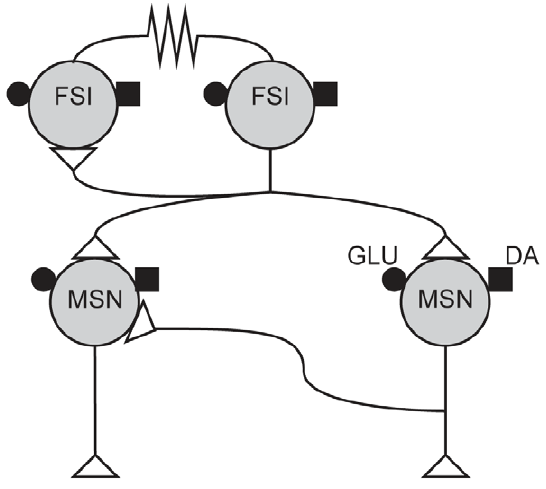
Figure 1. The striatal GABAergic microcircuit studied in this paper. Primary input to the striatum comes from glutamatergic (GLU: . ) fibres originating in the neocortex, thalamus, hippocampal formation and amygdala, and dopaminergic (DA: & ) fibres originating in the hindbrain dopaminergic neuron bands. The medium spiny neurons (MSNs) are interconnected via local collaterals of their axons projecting to other nuclei of the basal ganglia. The fast-spiking interneurons (FSIs) can form dendro-dendritic gap junctions between them; they may also be connected by standard axo-dendritic synapses. All these intra-striatal axo-dendritic connections ( D ) are GABAergic and hence inhibitory.